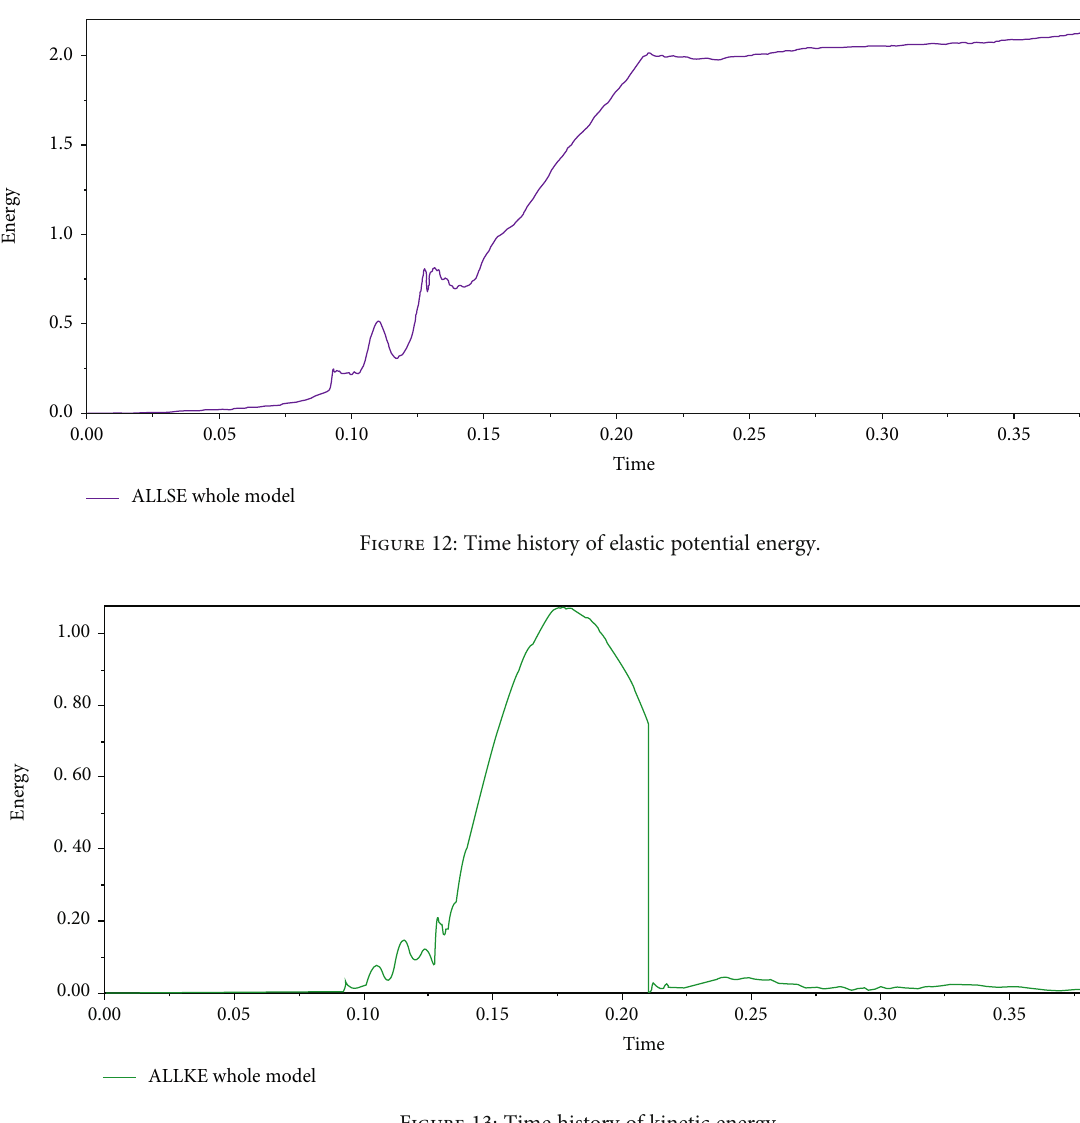
Figure 13: Time history of kinetic